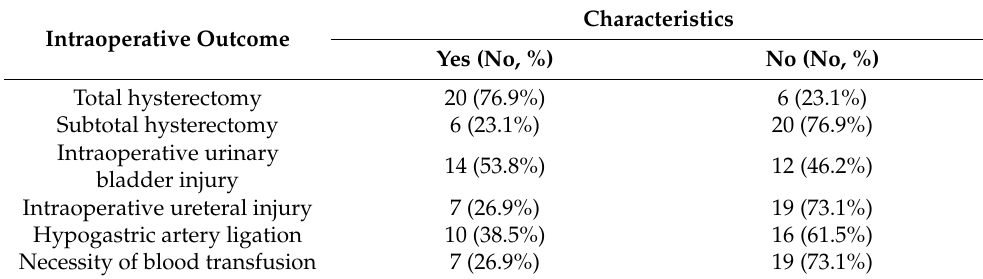
Table 2. Intraoperative outcome in the PAS-positive